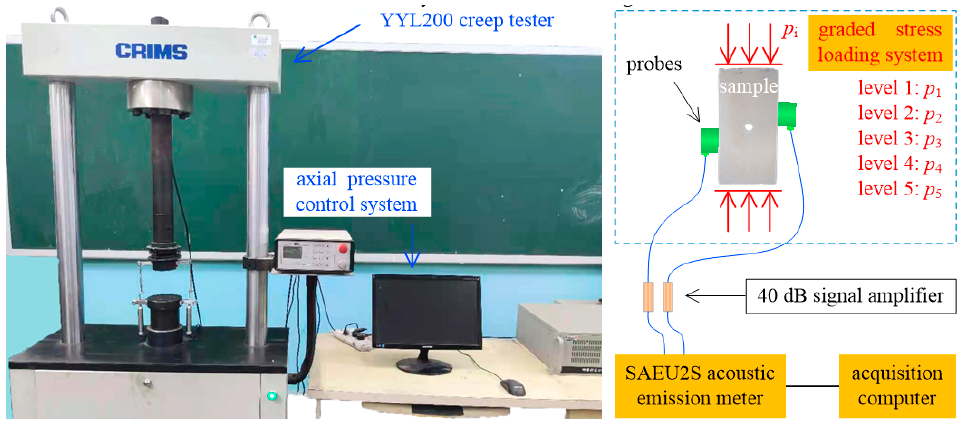
Figure 4. Acoustic emission test system.